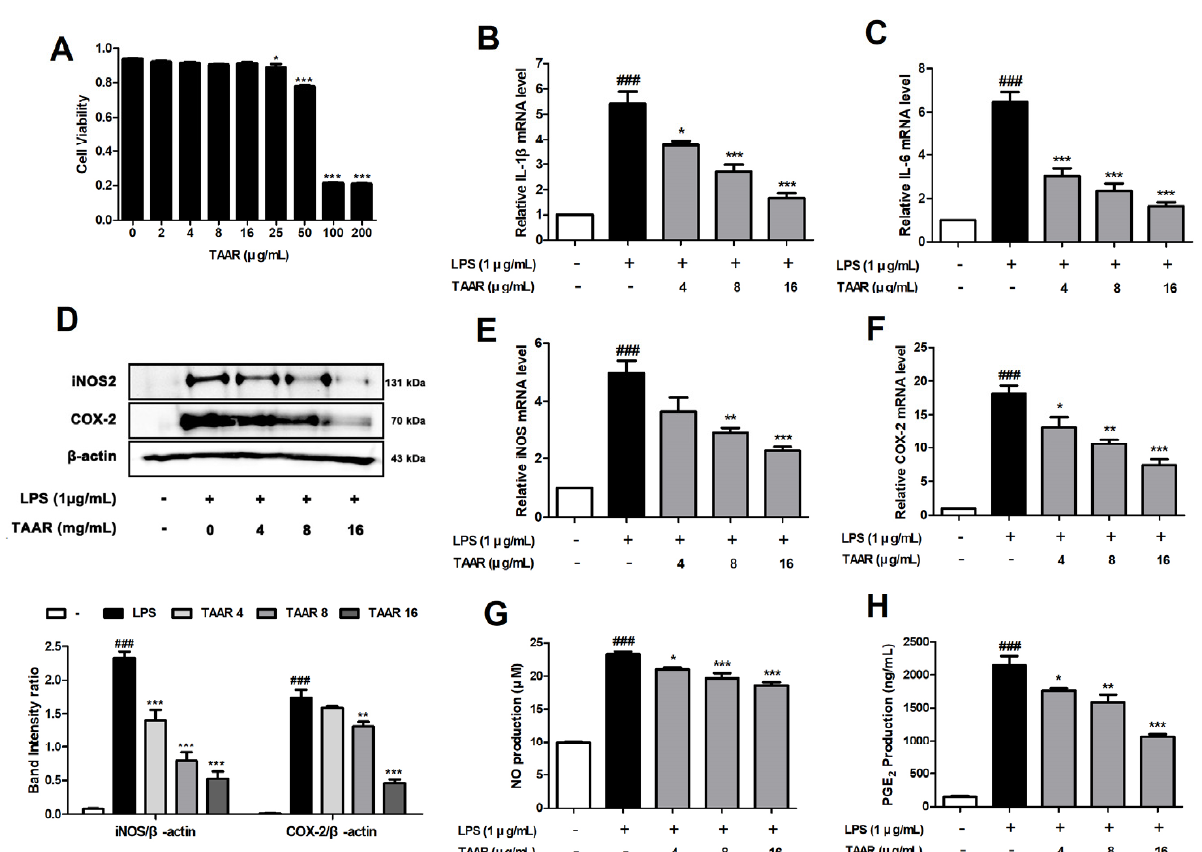
Figure 2. Effects of TAAR extract on the viability of and inflammatory response in LPS-induced RAW 264.7 cells. ( A ) Cytotoxicity of TAAR extract. mRNA levels of pro-inflammatory cytokines ( B ) IL-1 β and ( C ) IL-6 in LPS-induced RAW 264.7 cells. Protein levels of ( D ) iNOS and COX-2 and the mRNA levels of ( E ) iNOS and ( F ) COX-2 in LPS-induced RAW 264.7 cells. Expression levels of ( G ) NO and ( H ) PGE 2 in LPS-induced RAW 264.7 cells. All values are presented as the mean ± SEM of three experiments. Data were analyzed by Tukey’s post hoc test. ### p < 0.001 vs. no treatment group; * p < 0.05, ** p < 0.01, and *** p < 0.001 vs. LPS treatment only group.